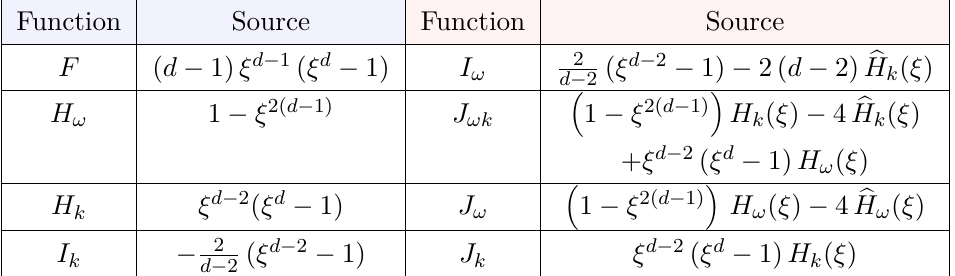
Table 1 . The sources for the functions parameterizing the ingoing solution for Z in (4.6) which enter their integral representation